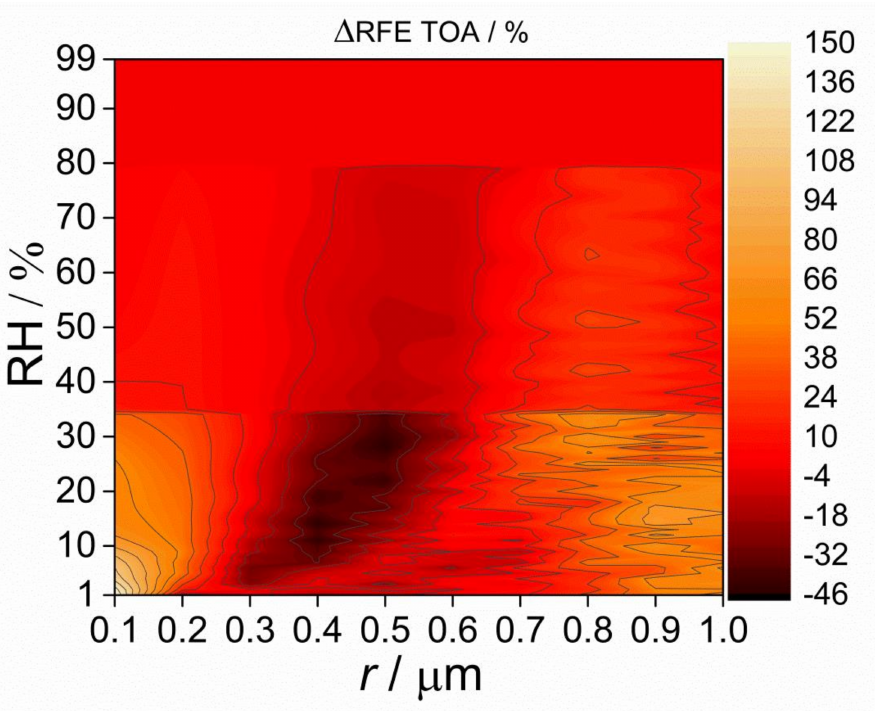
Figure 5. The radiative forcing efficiency differences, ∆ RFE, when the non-sphericity effect is